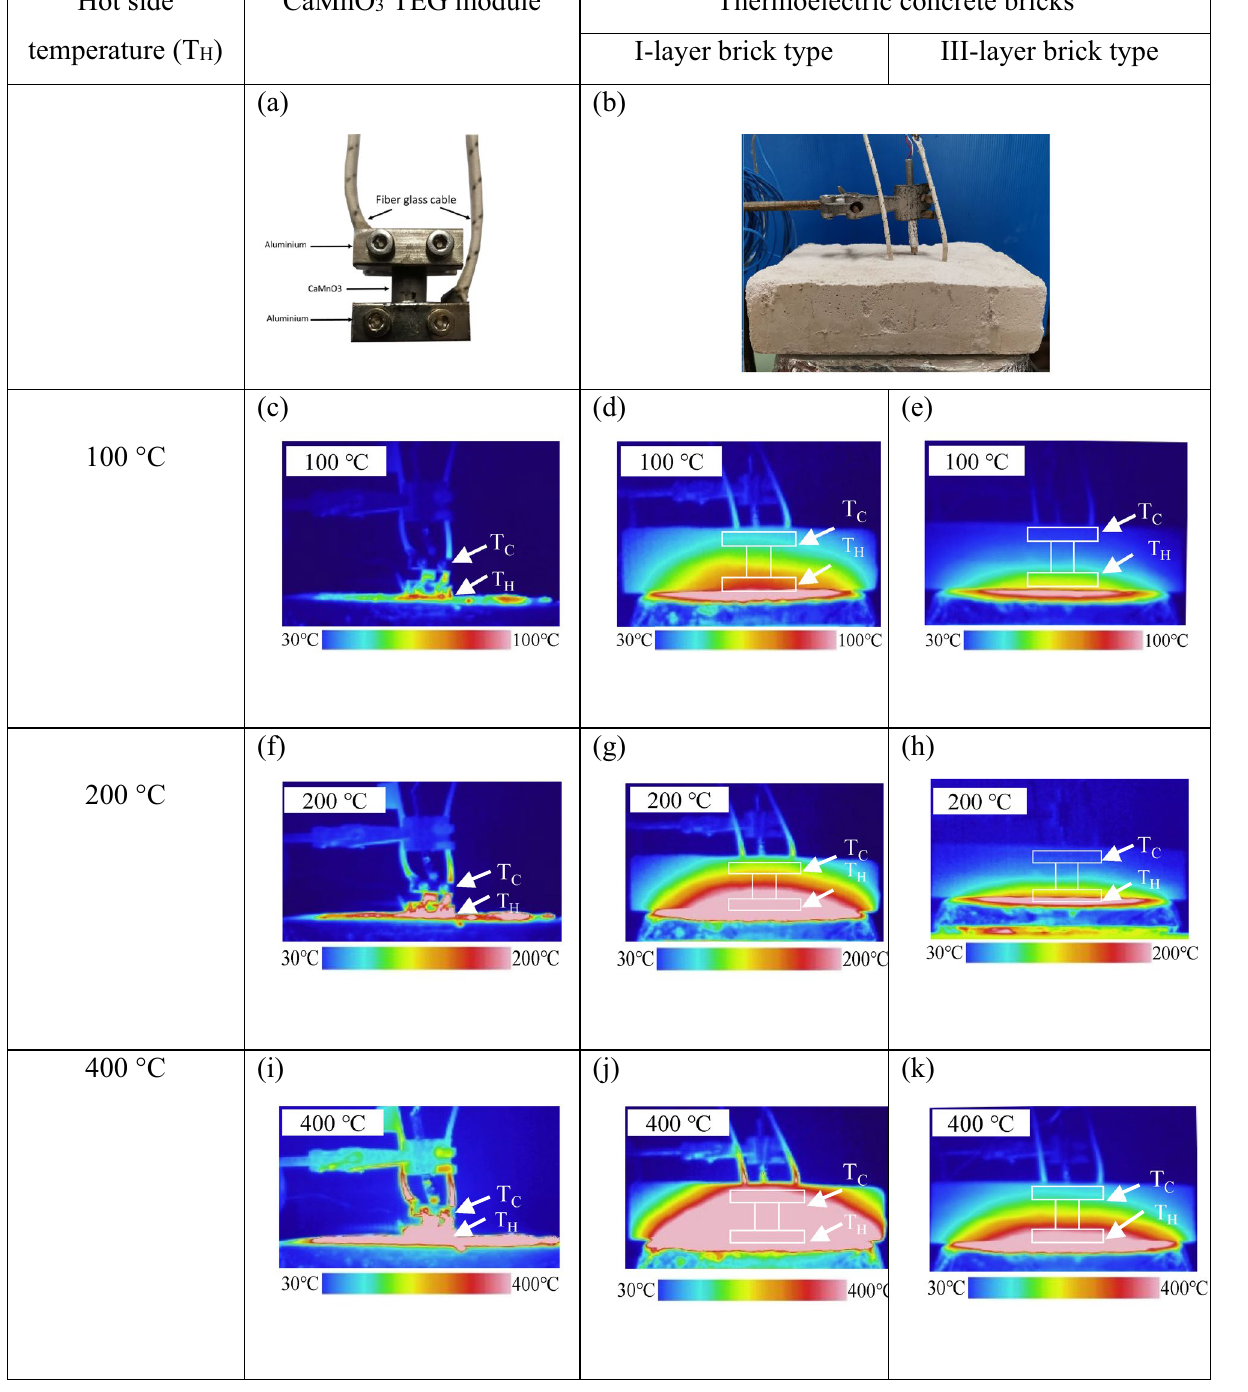
Figure 7. ( a ) The CaMnO 3 TEG module without thermal insulator, ( b ) The thermoelectric concrete bricks, the IR camera image using Keysight Technologies, U5856A (https:// www. keysi ght. com/)of ( c ) the CaMnO 3 TEG module, and ( d , e ) the thermoelectric concrete bricks of the I-layer brick type and the III-layer brick type when applying the hot side temperature at 100 °C, ( d – f ) for temperature at 200 °C, and ( g – i ) for temperature at 400